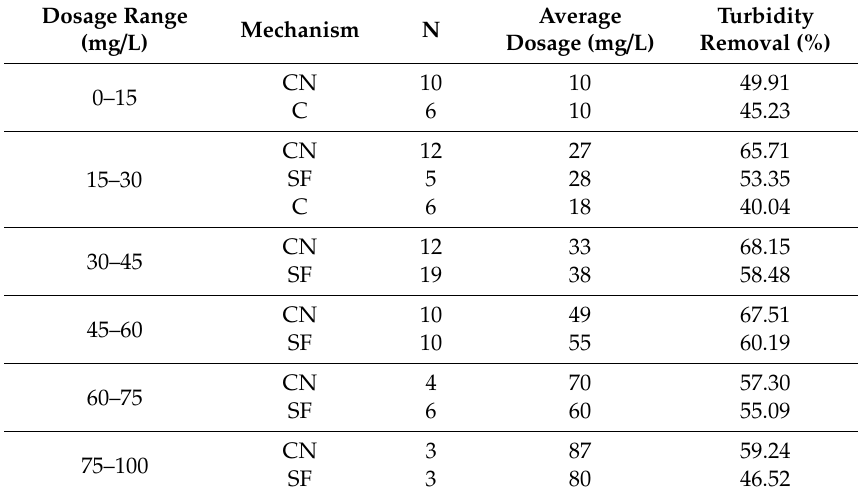
Table 6. Average turbidity removal for each sulfate aluminium dosage range and coagulation mechanism.